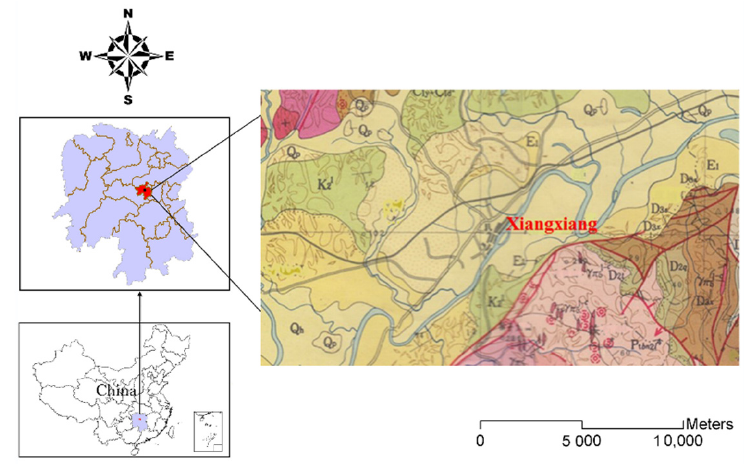
Figure 1. Geology of the study area.